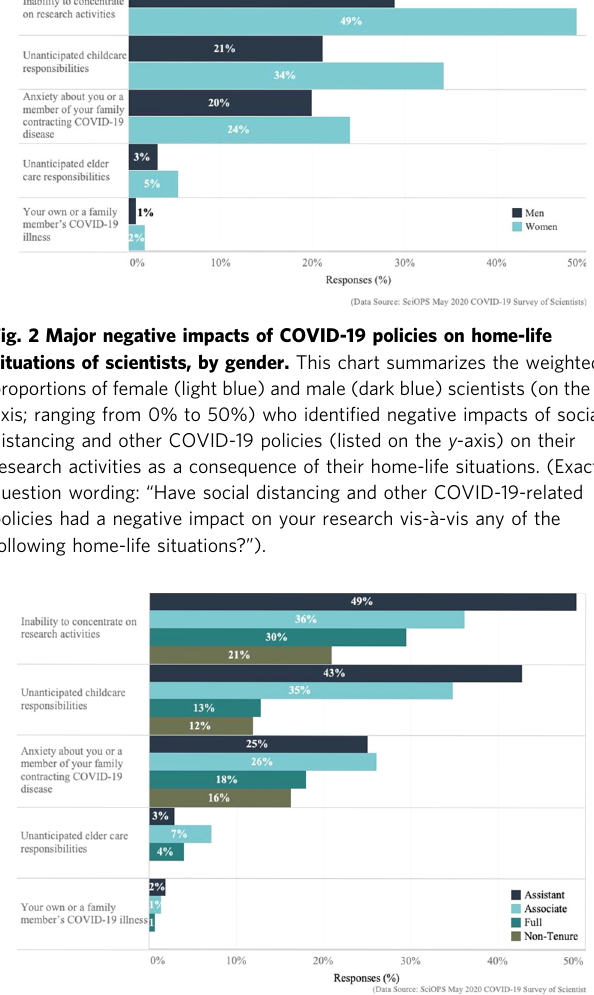
Fig. 3 Major negative impacts of COVID-19 policies on home-life situations of scientists, by rank. This chart summarizes the weighted proportions of scientists (on the x -axis; ranging from 0% to 50%) by faculty rank status as assistant professor (dark blue), associate professor (light blue), full professor (green), or non-tenure track (brown) who identi fi ed negative impacts of social distancing and other COVID-19 policies (listed on the y -axis) on their research activities as a consequence of their home-life situations. (Exact question wording: “ Have social distancing and other COVID-19-related policies had a negative impact on your research vis-à-vis any of the following home-life situations? ”